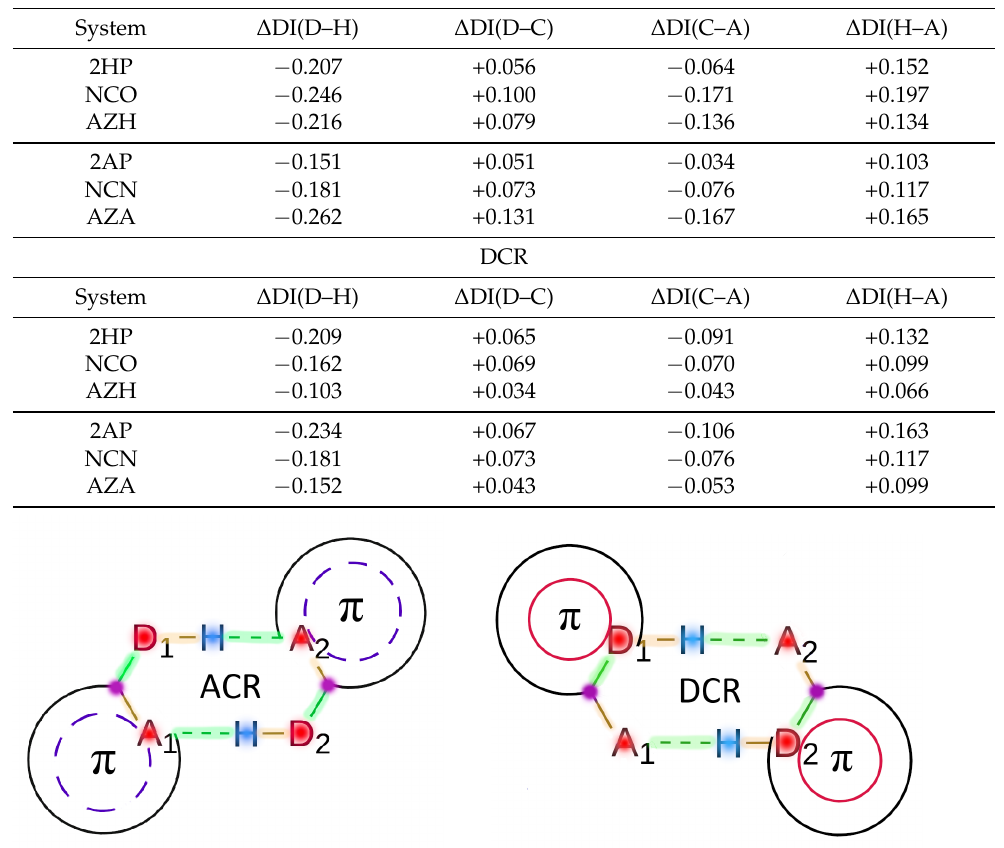
Figure 4. Representation of the major electronic changes induced by the dimerisation process in systems with (i) the hydrogen bond acceptor contained within the ring (ACR) and (ii) the hydrogen bond donor contained within the ring (DCR) displayed in the left and right parts of the Figure, respectively. Red and blue colors indicate QTAIM atoms with electronic charge accumulation and depletion, respectively, due to the formation of the molecular cluster. Ditto for green and orange bonds, employed to highlight an increase or decrease in the DI values. Purple is used to show not clearly established scenarios in this